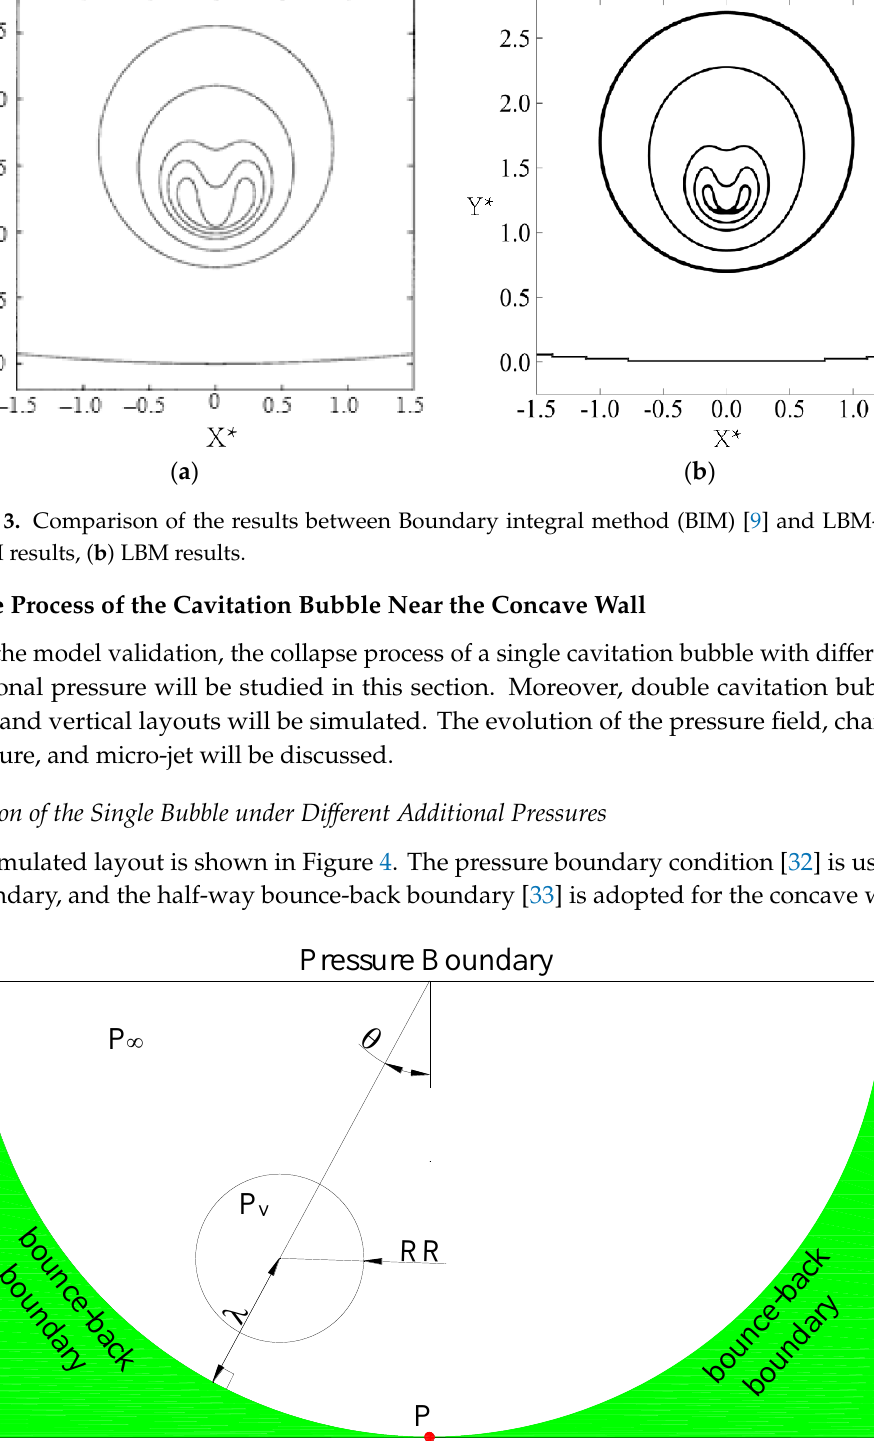
Figure 2. Comparison of the results between experimental image and simulation by LBM-MRT. ( a ) Experimental images [31], ( b ) simulation results.